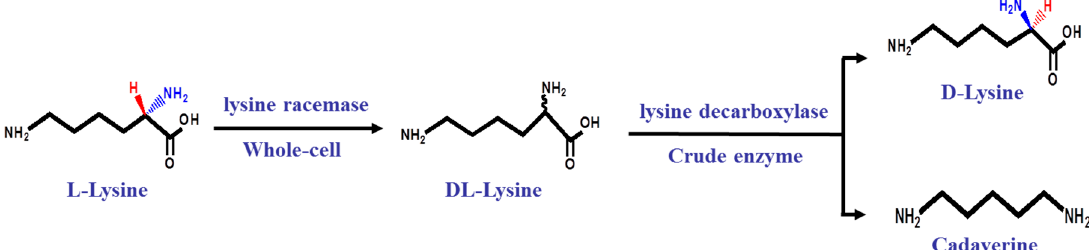
Figure 1. Scheme of enantiopure D -lysine production catalyzed by a two-enzyme cascade system of lysine racemase and lysine decarboxylase. The two enzymes were expressed in Escherichia coli (E. coli) respectively.